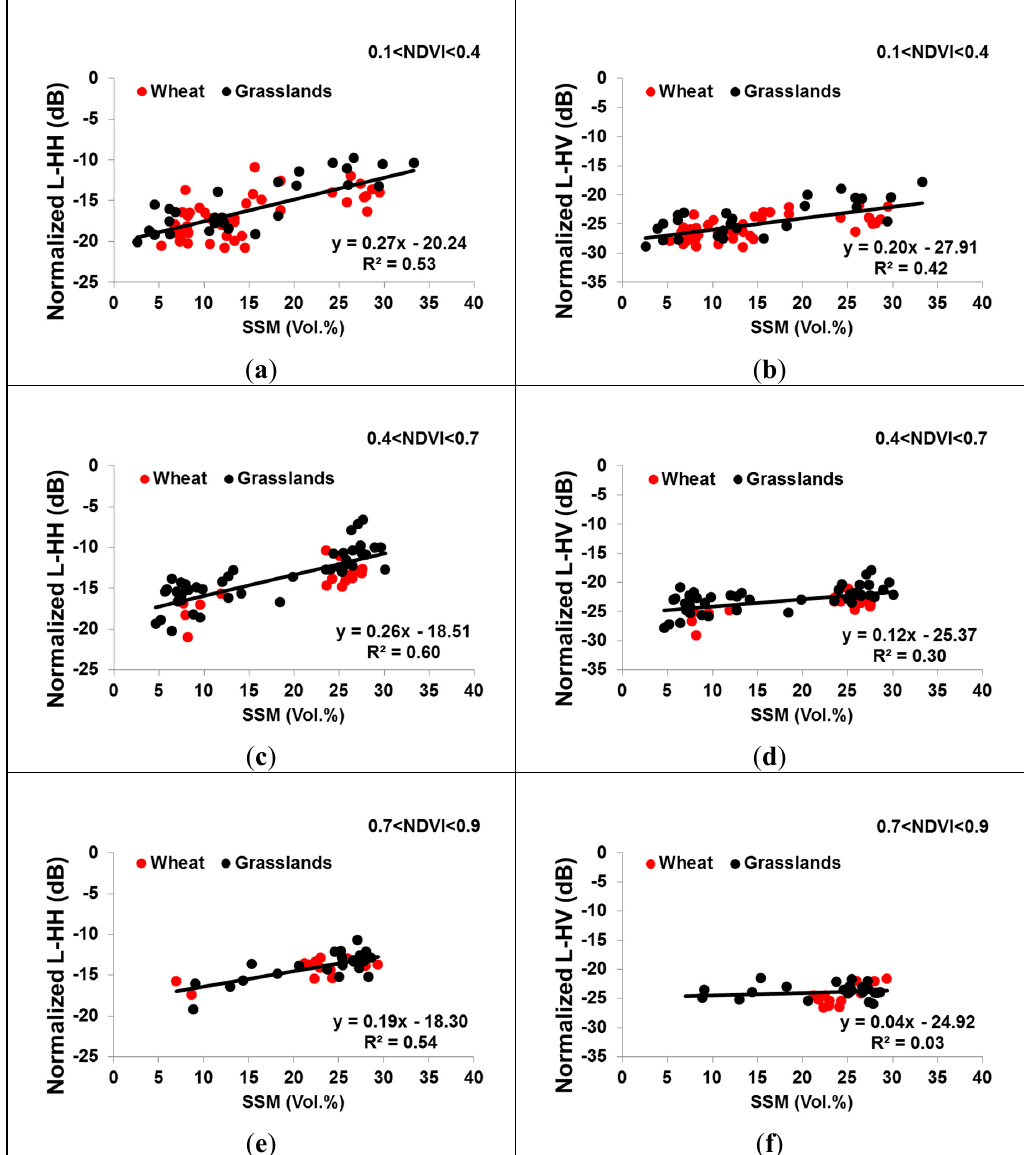
Figure 2. Sensitivity of the L-band backscattering coefficient as a function of SSM for three ranges of NDVI values. ( a ): L-HH and 0.1 < NDVI <0.4; ( b ): L-HV and 0 < NDVI <0.4; ( c ): L-HH and 0.4 < NDVI < 0.7; ( d ): L-HV and 0.4 < NDVI<0.7; ( e ): L-HH and 0.7 < NDVI < 0.9; ( f ): L-HV and 0.7 < NDVI < 0.9.